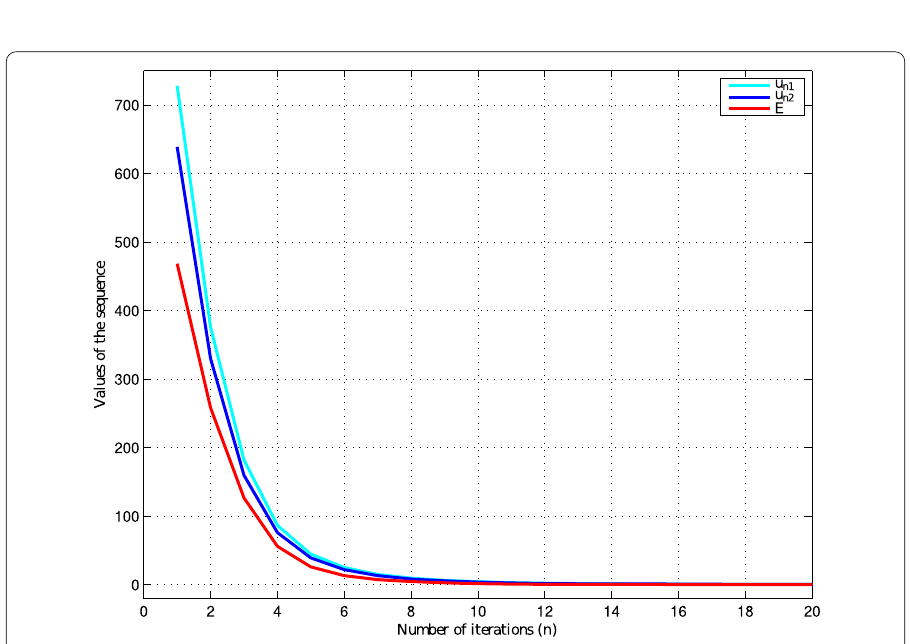
Figure 8 Convergence result of Theorem 3.11 with starting point of Case